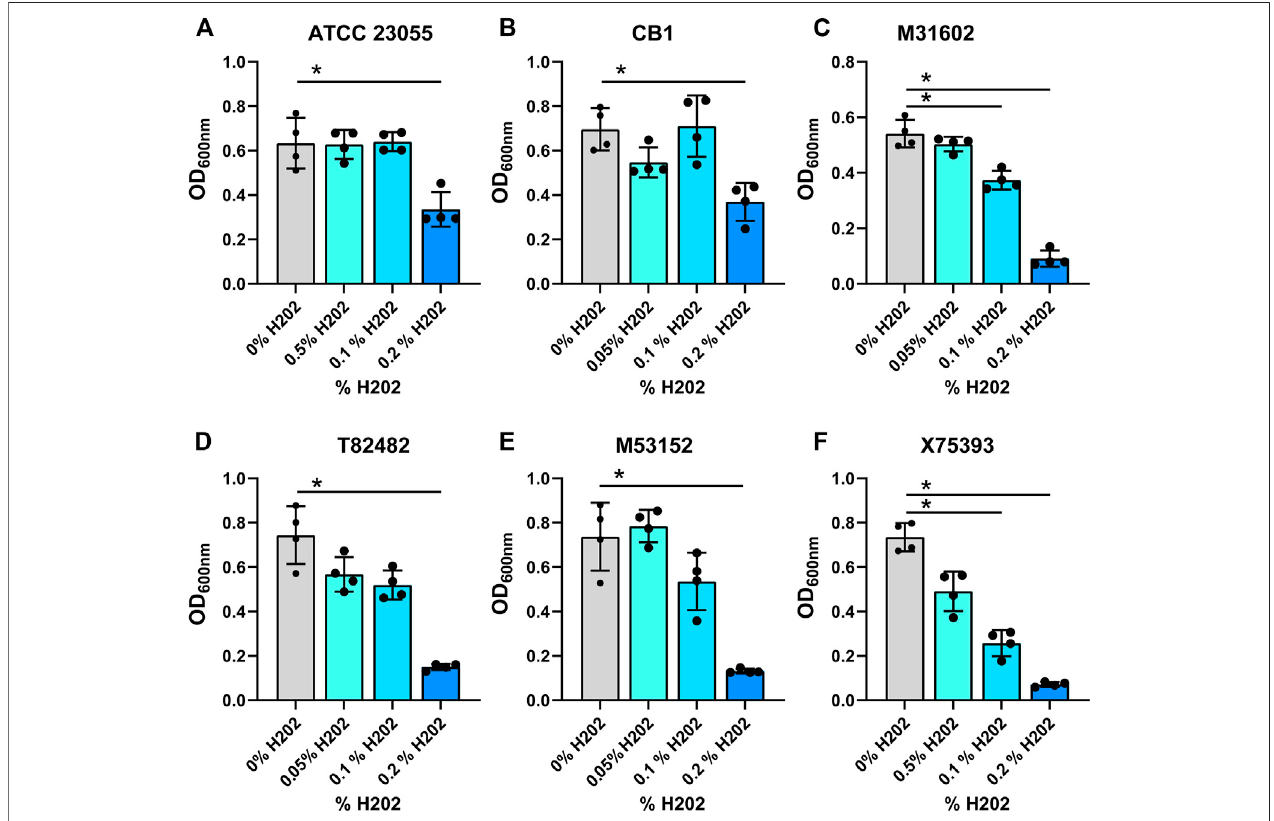
FIGURE 4 | (A) calcoaceticus growth in hydrogen peroxide. Growth of A. calcoaceticus strains as measured by OD 600nm after 18 h of incubation. Growth was examined in the following strains: (A) ATCC 23055, (B) CB1; clinical isolates: (C) M31602, (D) T82482, (E) M53152, and (F) X75,393). * p < 0.05, One Way ANOVA.